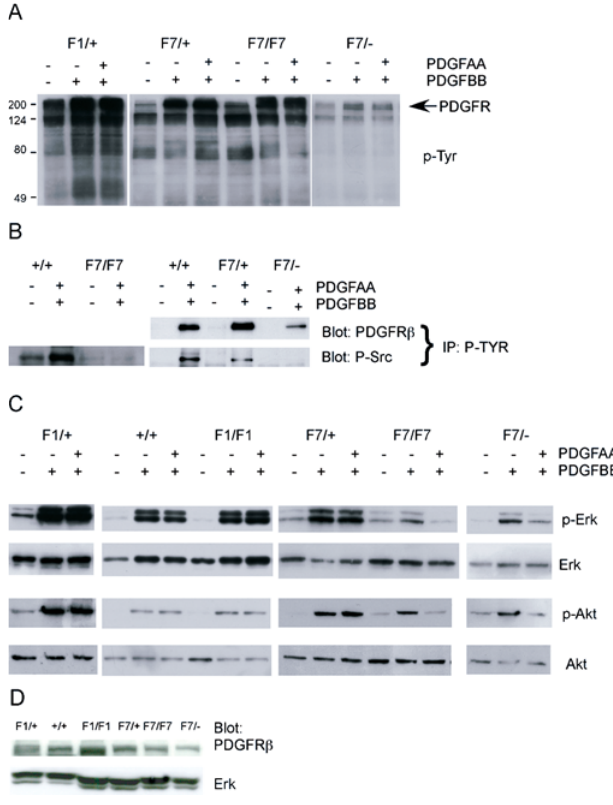
Figure 10. Biochemistry of MEFs from F7 and F1 Mice (A) Whole-cell lysates were generated from MEFs that were unstimulated or stimulated with PDGFAA and/or PDGFBB alone, 100 ng/ml and 30 ng/ml, respectively. Lysates were then subjected to SDS–PAGE and Western blotting accomplished with the anti- phosphotyrosine antibody (4G10). (B) Immunoprecipitation of tyrosine-phosphorylated proteins from wild-type and the F7 series of mutant MEFs. The precipitates were then run on SDS–PAGE, and a Western blot was performed using anti-Src [pY 418 ] antibody and anti-PDGFR b 97A. (C) Whole-cell lysates from unstimulated or stimulated MEFs. Lysates were then subjected to SDS–PAGE and Western blotting accom- plished with the indicated phosphorylated-specific antibodies. Blots were stripped and blotted with antibodies to the corresponding unphosphorylated proteins to demonstrate protein loading. Data are representative of multiple experiments from at least two indepen- dently derived cell lines. (D) Western blots of whole-cell lysates from 5 3 10 4 cells per lane blotted with antibodies to PDGFR b (06-498) and ERK as a loading control. DOI: